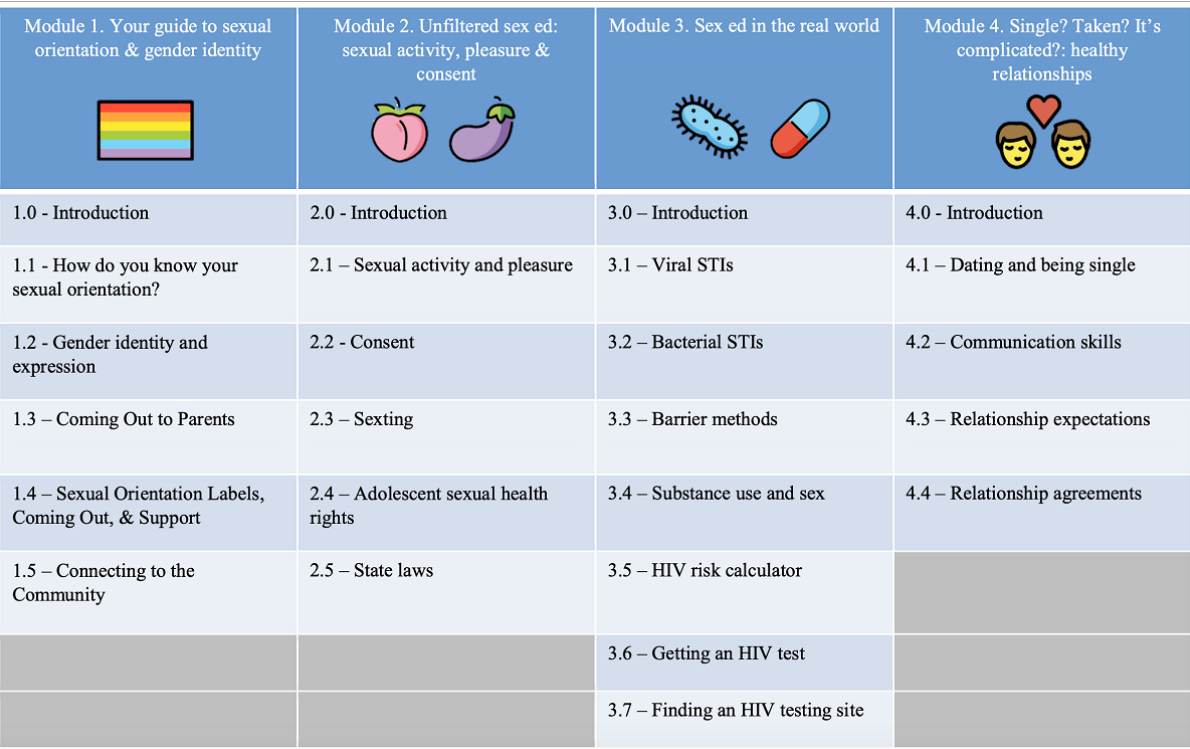
Figure 3. Overview of the 4 SMART Sex Ed modules. STI: sexually transmitted